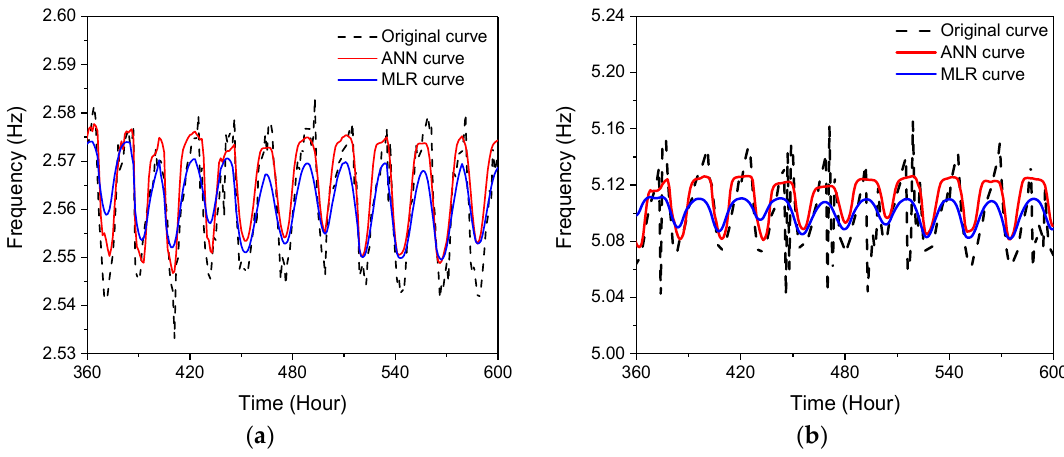
Figure 20. Comparison of ANN and PR in the fitting of identified frequencies: ( a ) the 5th mode; ( b ) the 8th